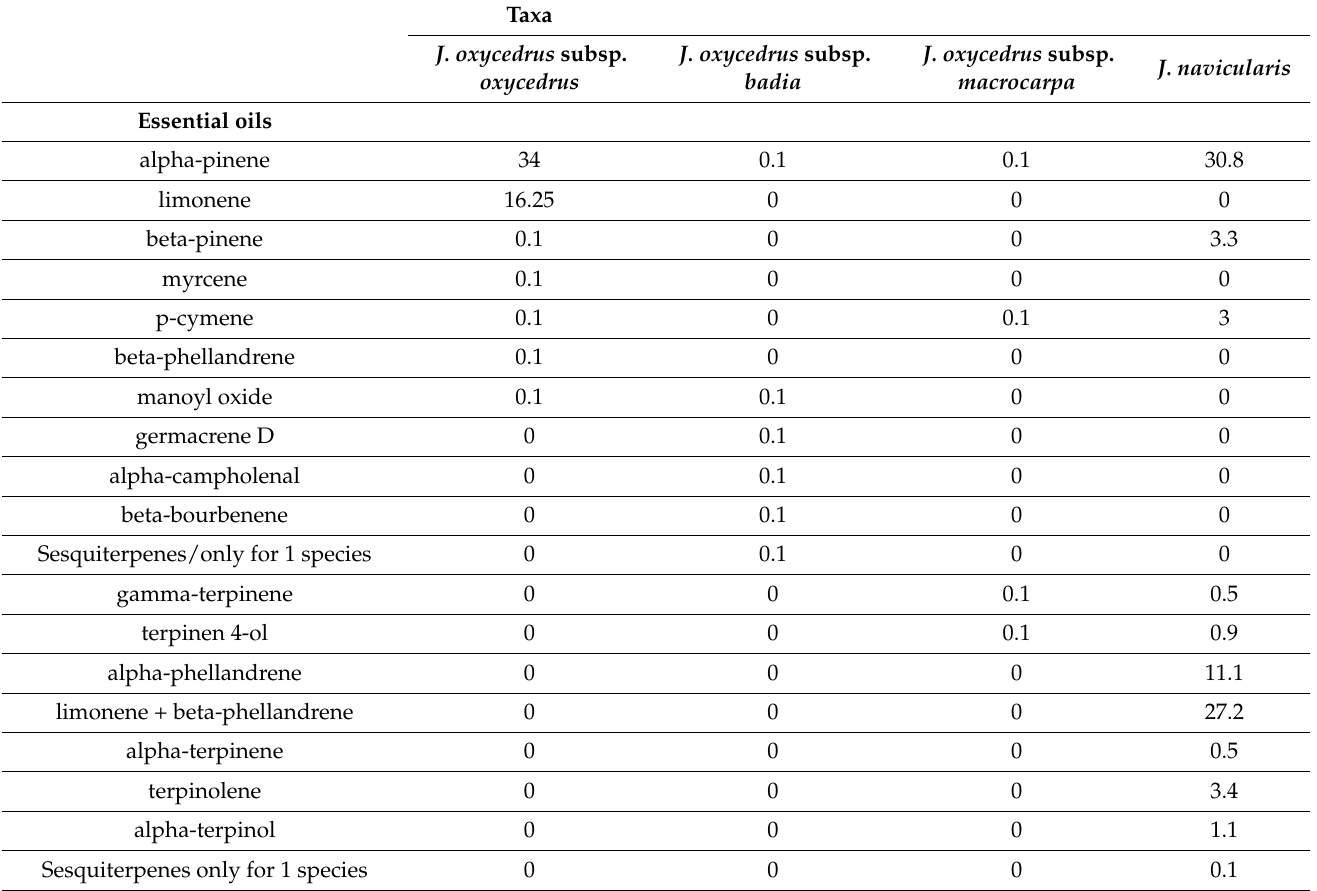
Table 2. Essential oil content in four Juniperus species. Units of measure in gr, values in %, from [31,32]. Taxa J. oxycedrus subsp. J. oxycedrus oxycedrus